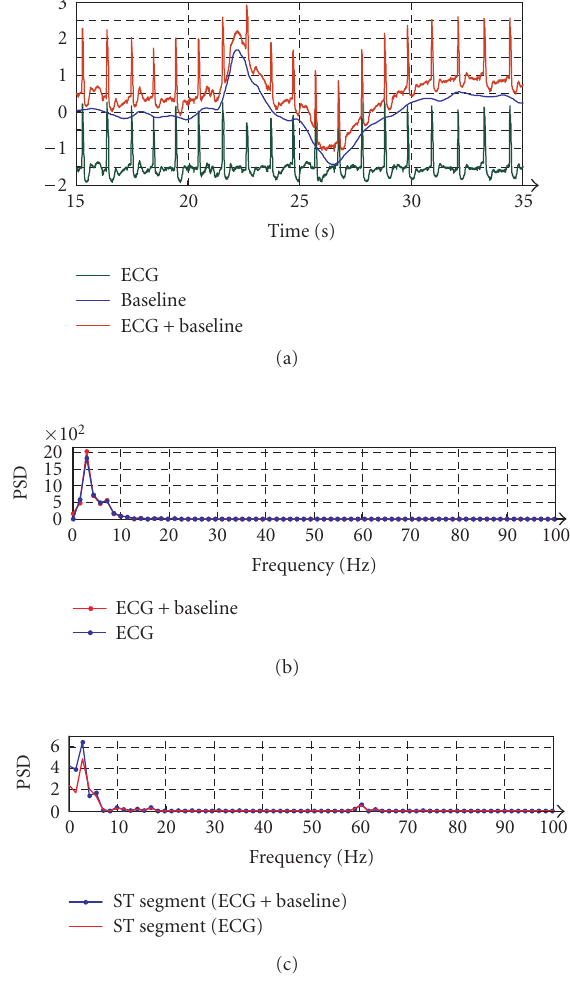
Figure 10: (a) 20 seconds of record “b108-2” highlighted, (b) power spectrum density of record “b108-2,” and (c) power spectrum den- sity of ST-segments of record